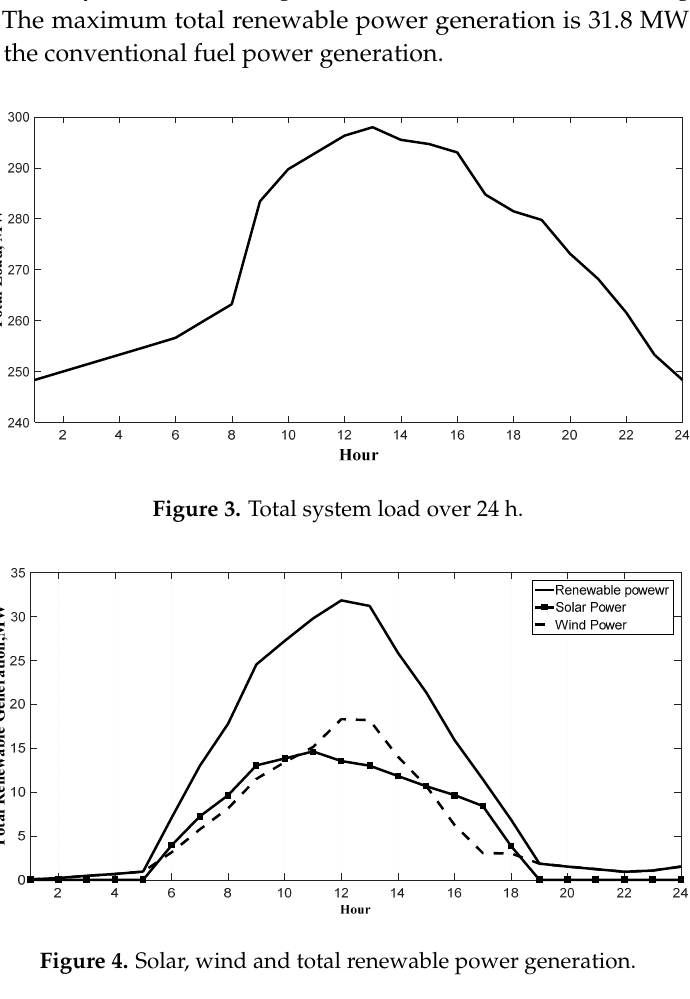
Table 1. Comparison of different methods to 30-bus power system model. GA: genetic algorithm; RGA: real genetic algorithm; OPF: optimal power flow.